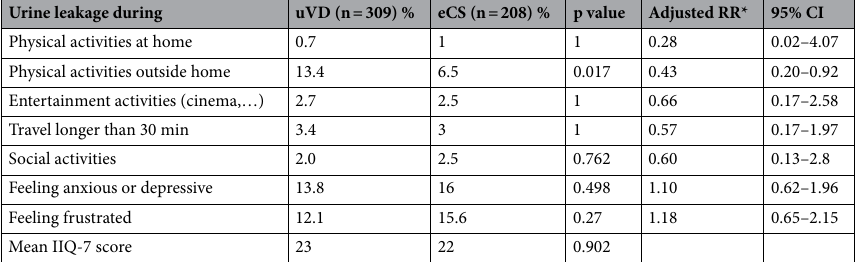
Urine leakage during